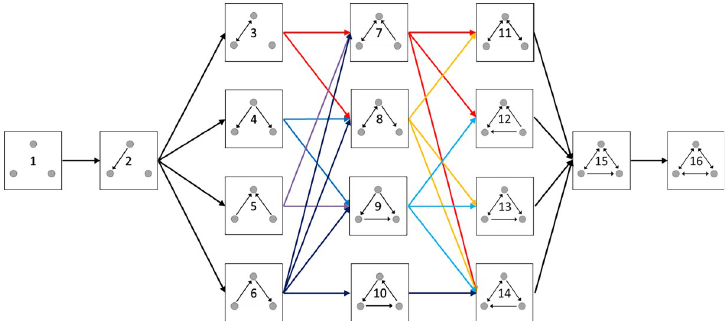
Fig 6. Conceptual figure of potential step-wise triad transitions, where transition is characterized by the gain of an antibiotic phenotype that specifically inhibits one other triad member or the loss of an antibiotic resistance phenotype. These transitions may occur as a result of demographic changes in communities or evolutionary